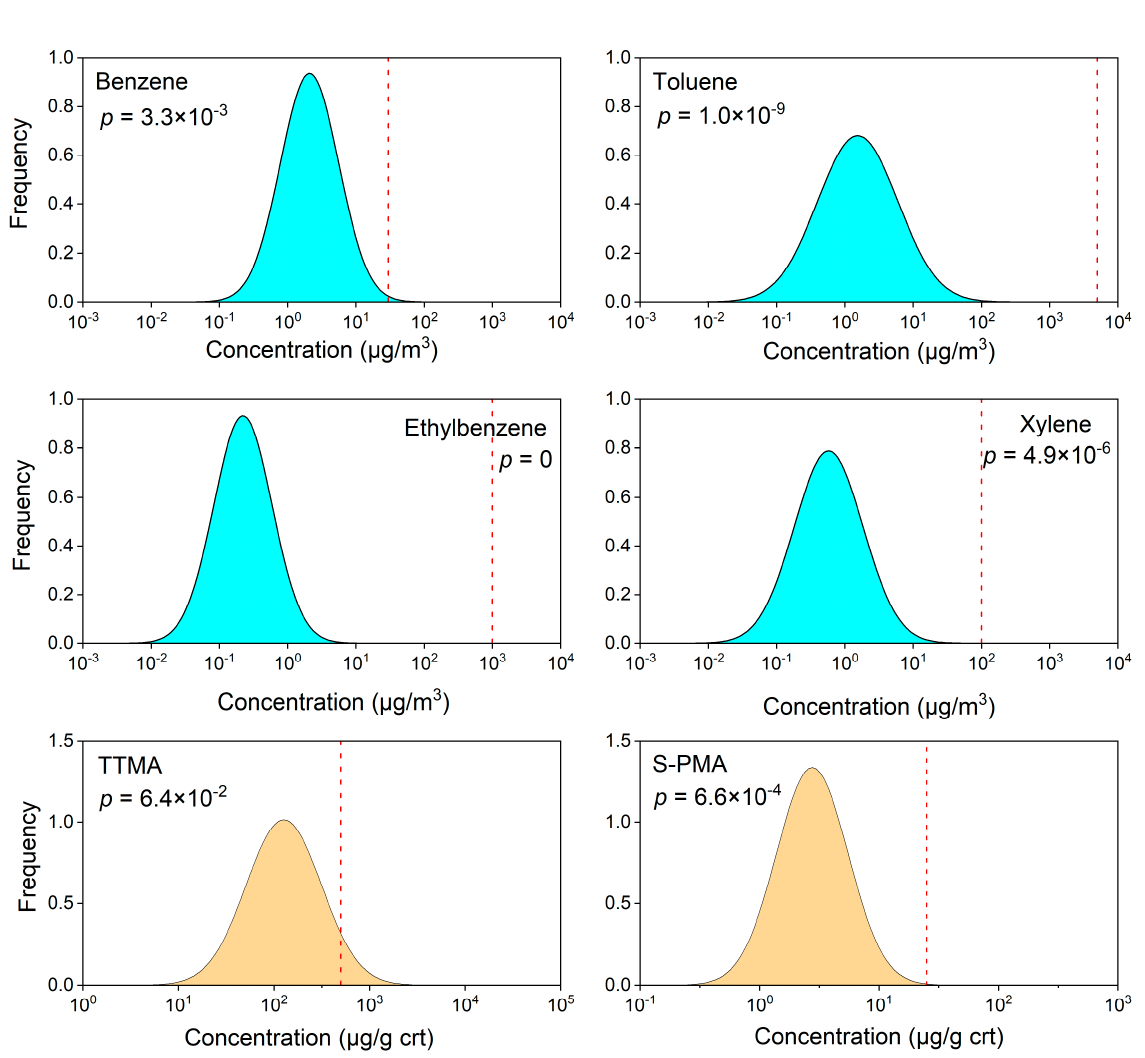
Figure 5. Distribution of atmospheric BTEX concentrations in residential areas and urinary biomarker concentrations from residents. Vertical lines represent noncancer risk threshold reference concentrations.